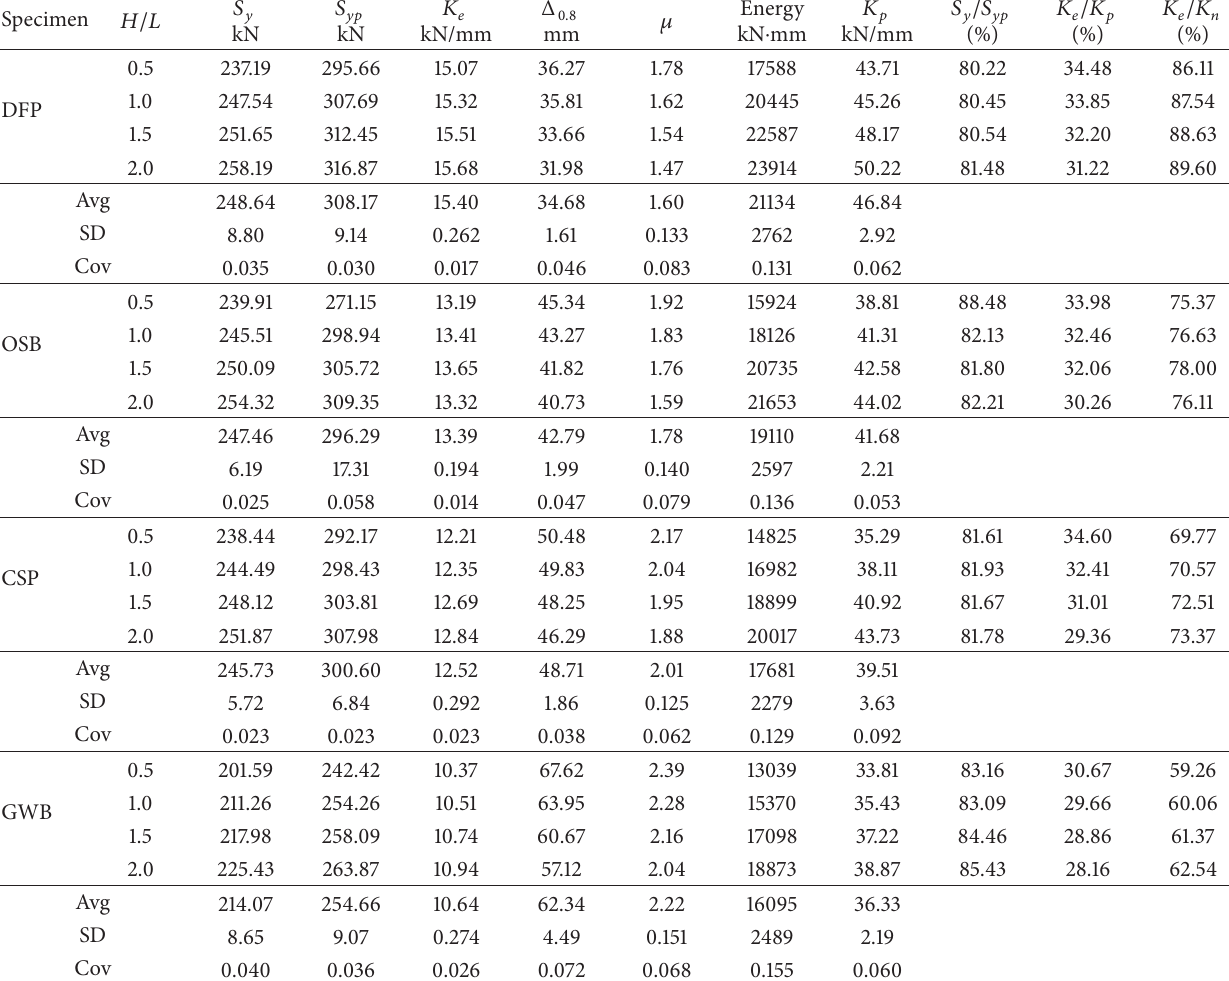
Table 7: Monotonic loading specimens of 2-side sheathed CFS results with thickness of 12.5 mm.